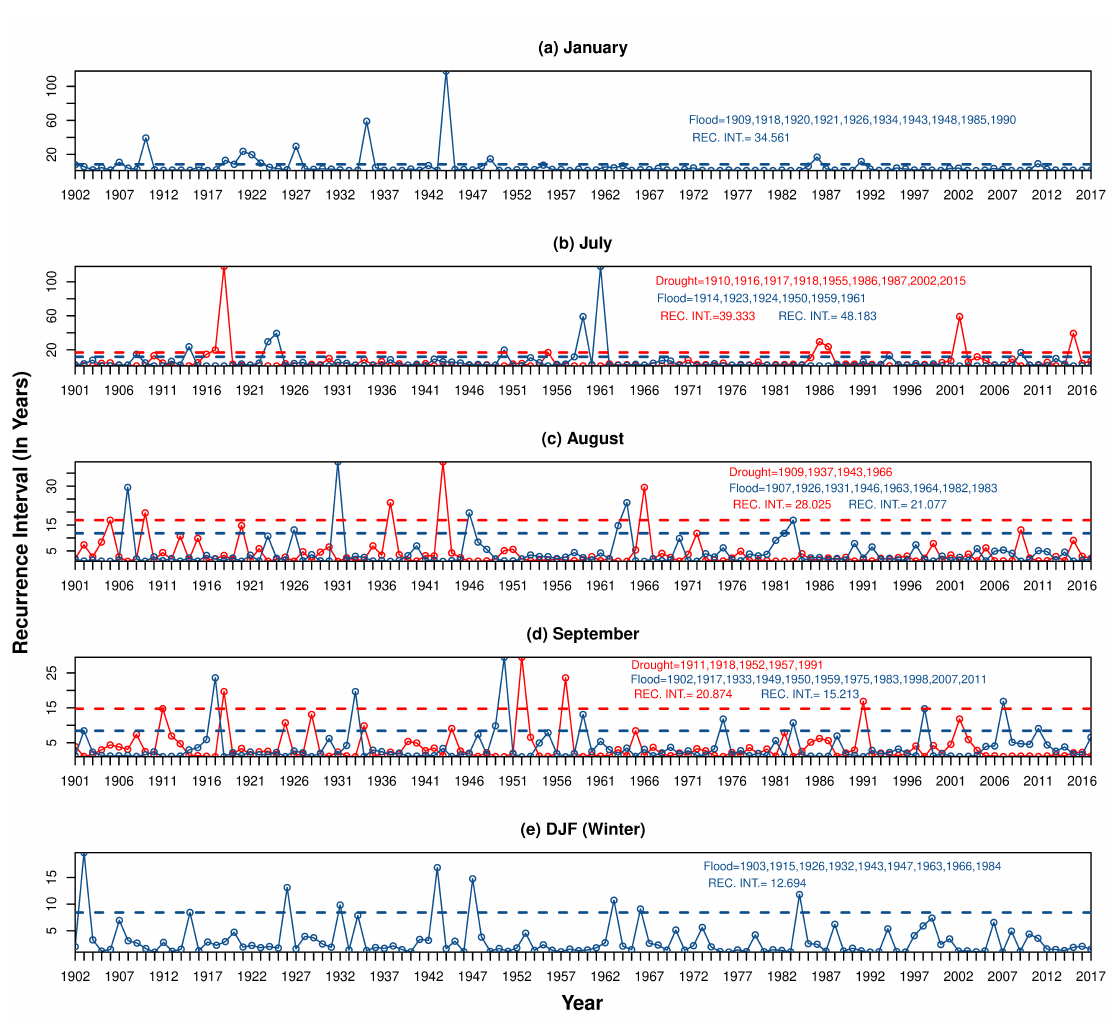
Figure 7. ( a – e ) Recurrence interval trend of the excess (+1.5 SD) and deficit ( − 1.5 SD) rainfall periodic events for the period 1901–2017. The blue solid line with the blue circular mark (red solid line with red circular mark) represents the recurrence interval of the excess (deficit) periodic events. Dashed blue (red) line, parallel to the x-axis marks the limit of +1.5 SD ( − 1.5 SD). The trend shown here is significant at a 90% level and the circular mark on the recurrence interval trend line represent the exact point of the year on the